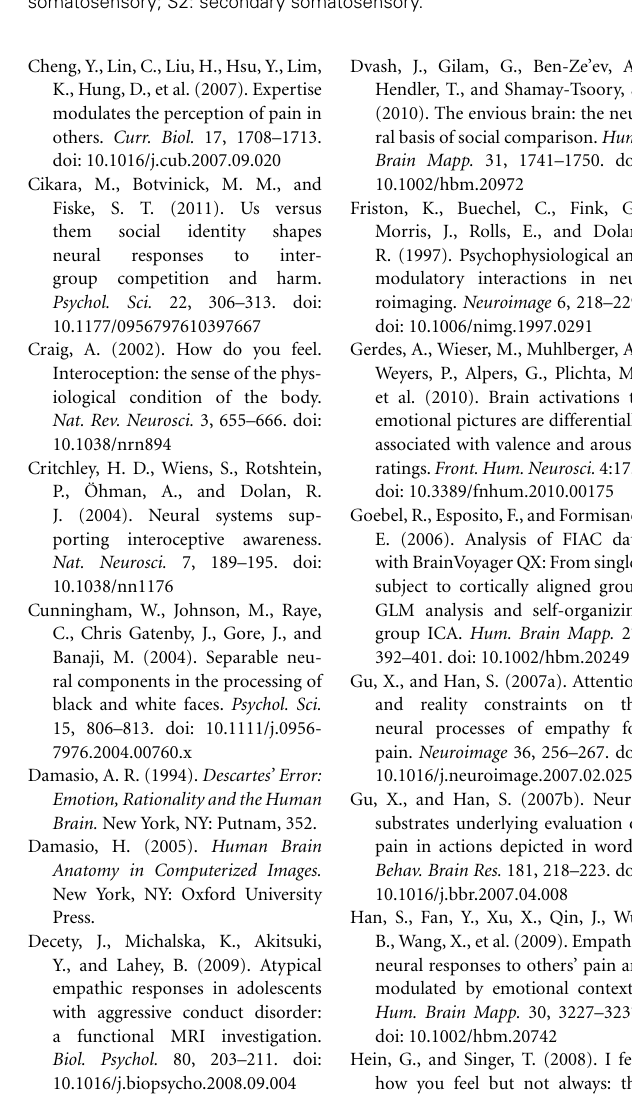
Supplementary Figure S1 | Citations for commonly cited roles for regions of interest. (A) 1 (Knutson and Cooper, 2005); 2 (Yeung and Cohen, 2006); 3 (Shackman et al., 2011). (B) 1 (O’Doherty et al., 2004); 2 (Jankowski et al.,